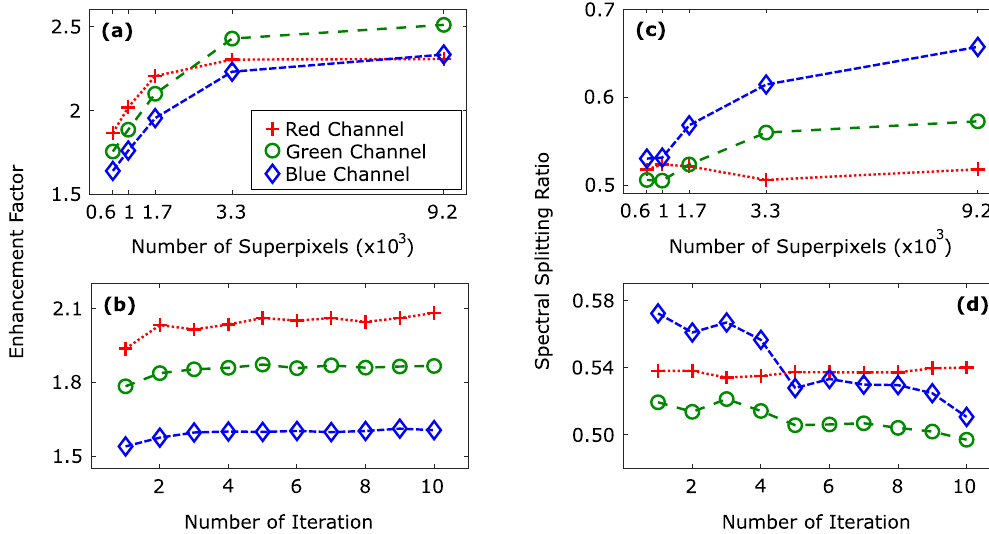
Figure 4. The enhancement factor of intensity for each channel as a function of ( a ) number of superpixels and ( b ) number of major iterations. The spectral splitting ratio for each channel as a function of ( c ) number of superpixels ( d ) number of major iterations. The error bars are smaller than the symbol size in all